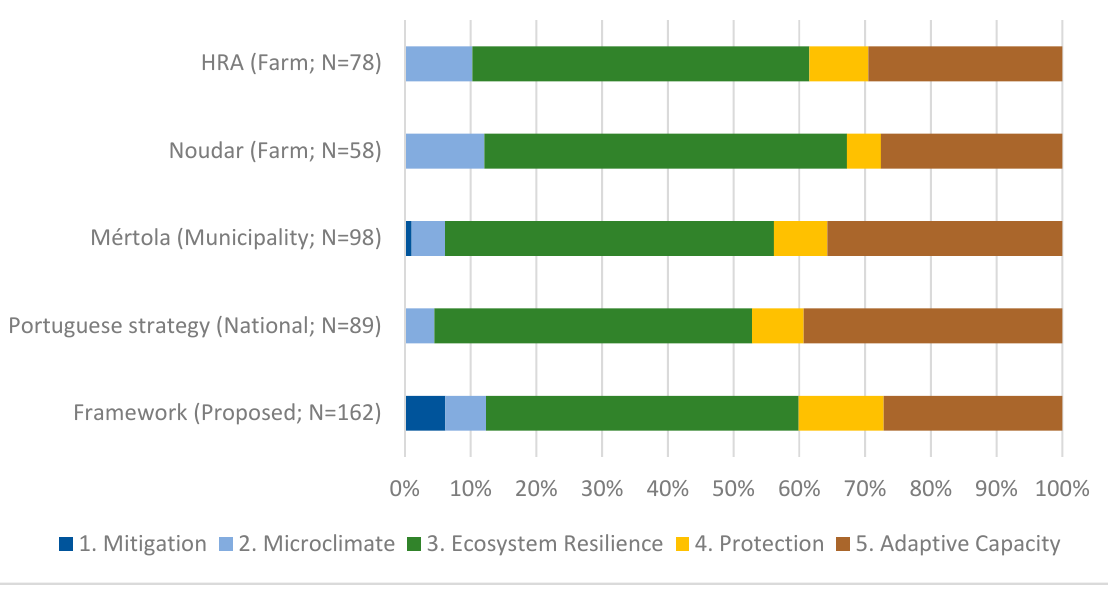
Figure 5. Percentage of adaptation measures per adaptation strategy identified in the three case studies adaptation plans, plus the Portuguese National Adaptation Strategy in comparison to the proposed Framework.